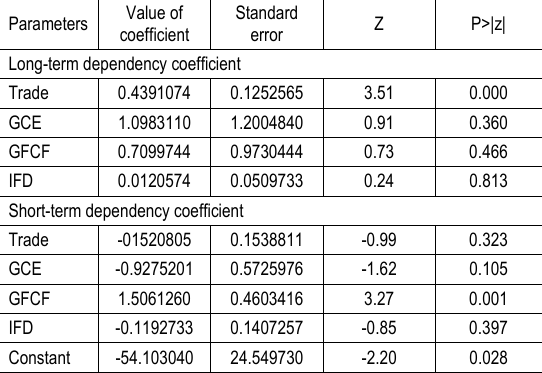
Table 10. The results of MG approach to